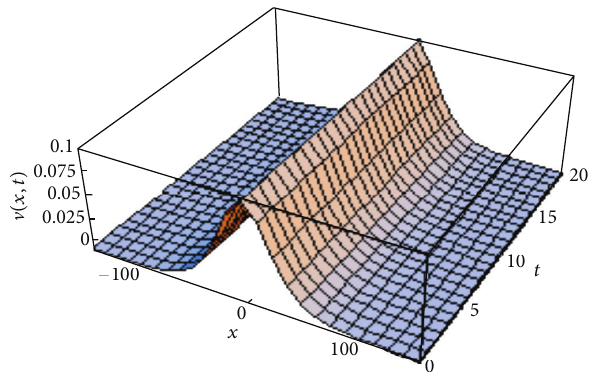
Figure 5: Approximate solution of FJM equation.